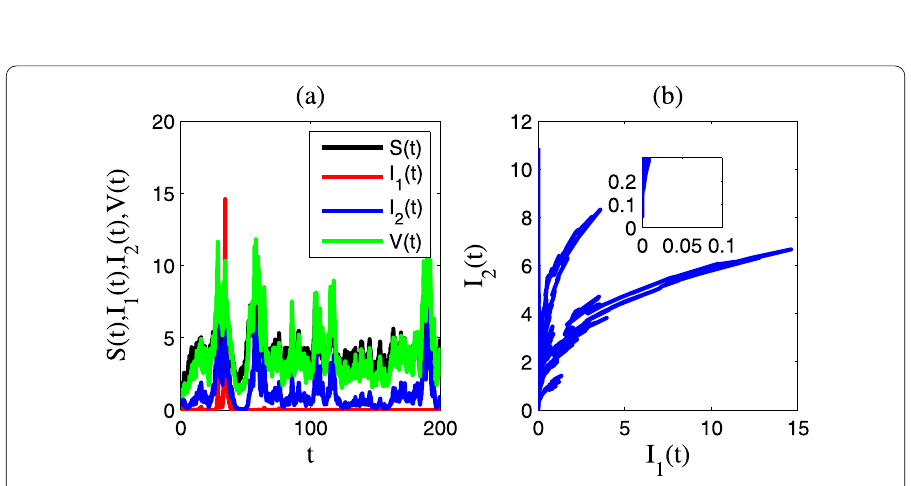
Figure 3 Time sequence diagram and phase diagram of model (4) for extinctions of disease 2 and persistence of disease 1.